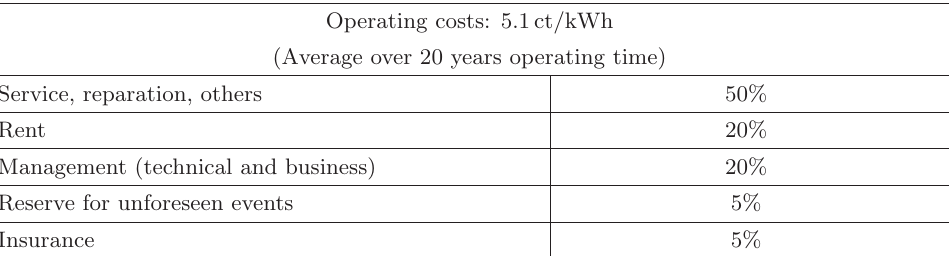
Table IV. – The typical operating costs of a 2 MW onshore wind power station in Germany (Status 2013). Data taken from WindGuard GmbH,